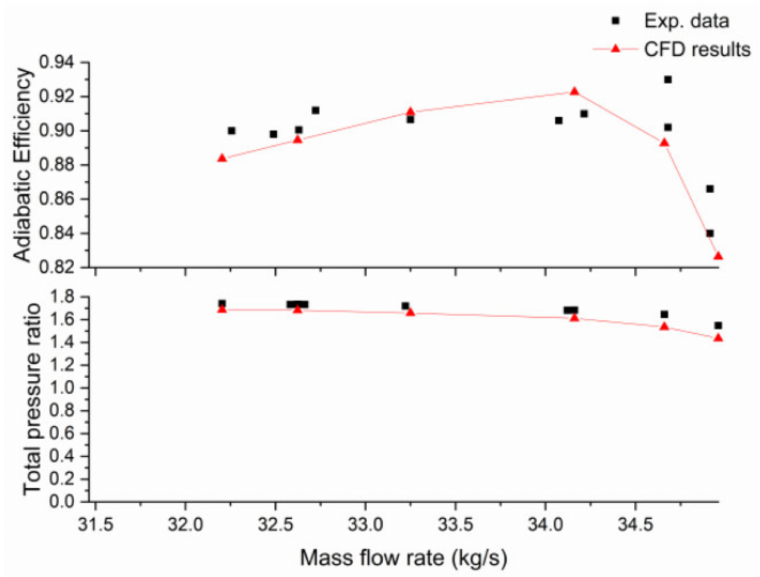
Figure 6. Comparison of CFD results against experimental